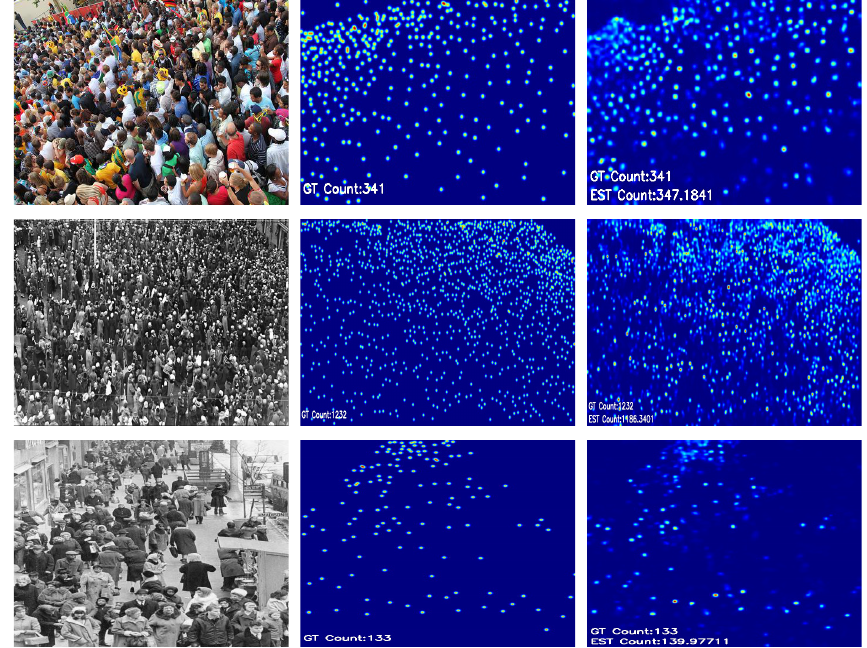
Figure 4: The density map estimated by MSA-CNN on the Shanghai Tech Part_B dataset, the first column is test images, the second column is ground truth density map, and the third column is the estimated density map by our approach(MSA-CNN). Table 2: Comparison results on ShanghaiTech